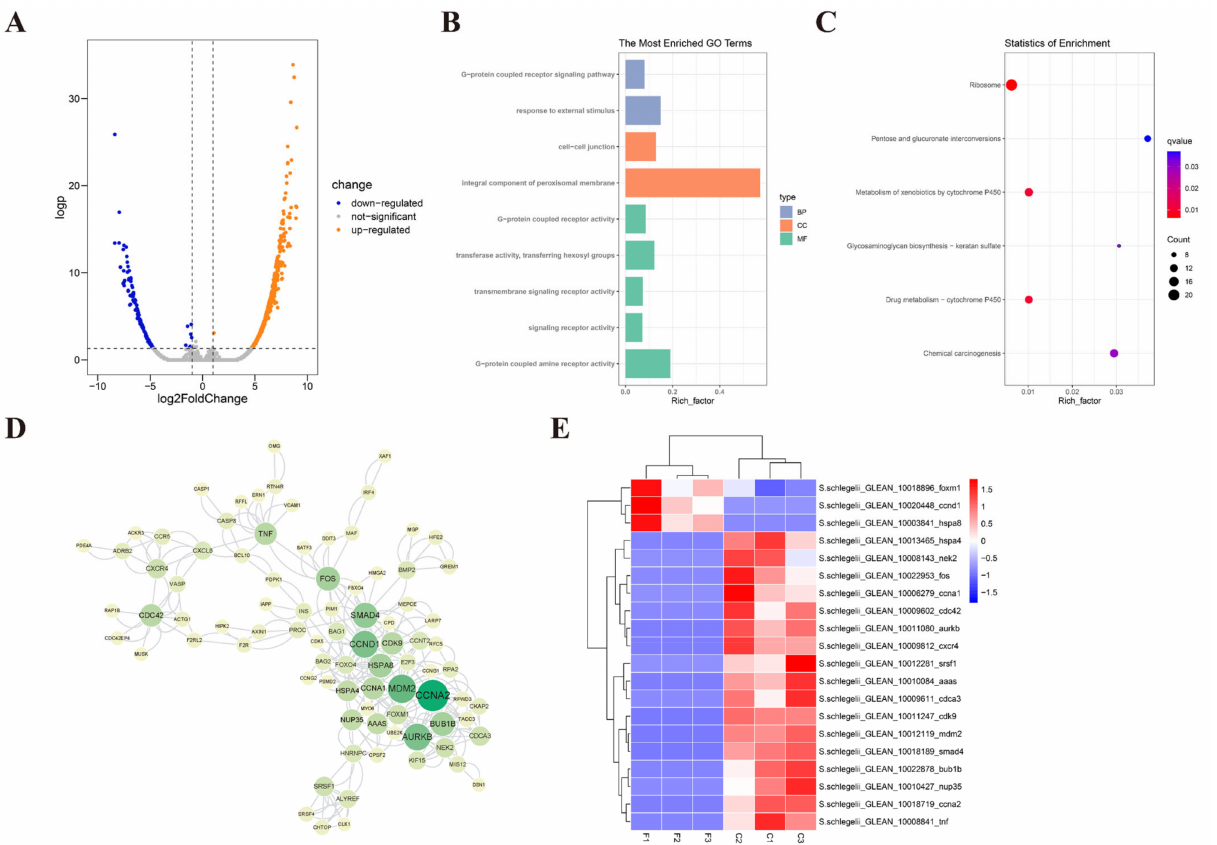
Figure 5. Methylation analysis of sperm with the cryodiluent (FBS + 15% Gly). ( A ) DMGs in the methylome profile of cryopreserved sperm. One thousand two hundred sixty-six DMGs were identified, including 261 downregulated genes and 1005 upregulated genes. ( B ) GO enrichment analysis of DMGs. Statistical significance was accepted when q-value < 0.05. ( C ) KEGG enrichment analysis of DMGs. Statistical significance was accepted when q-value < 0.05. ( D ) The PPIN of DMGs. The PPIN was constructed by STRING database and visualized using Cytoscape software. The node size is positively correlated with degree. ( E ) The expression pattern of key DMGs with a degree of 10 or above identified in PPIN. The x-axis showed sampled tissues, with the prefix F for sperm without cryopreservation and C for sperm with cryopreservation, and the y-axis shows genes. The color scale showed standardized RPKM values normalized by Z-score